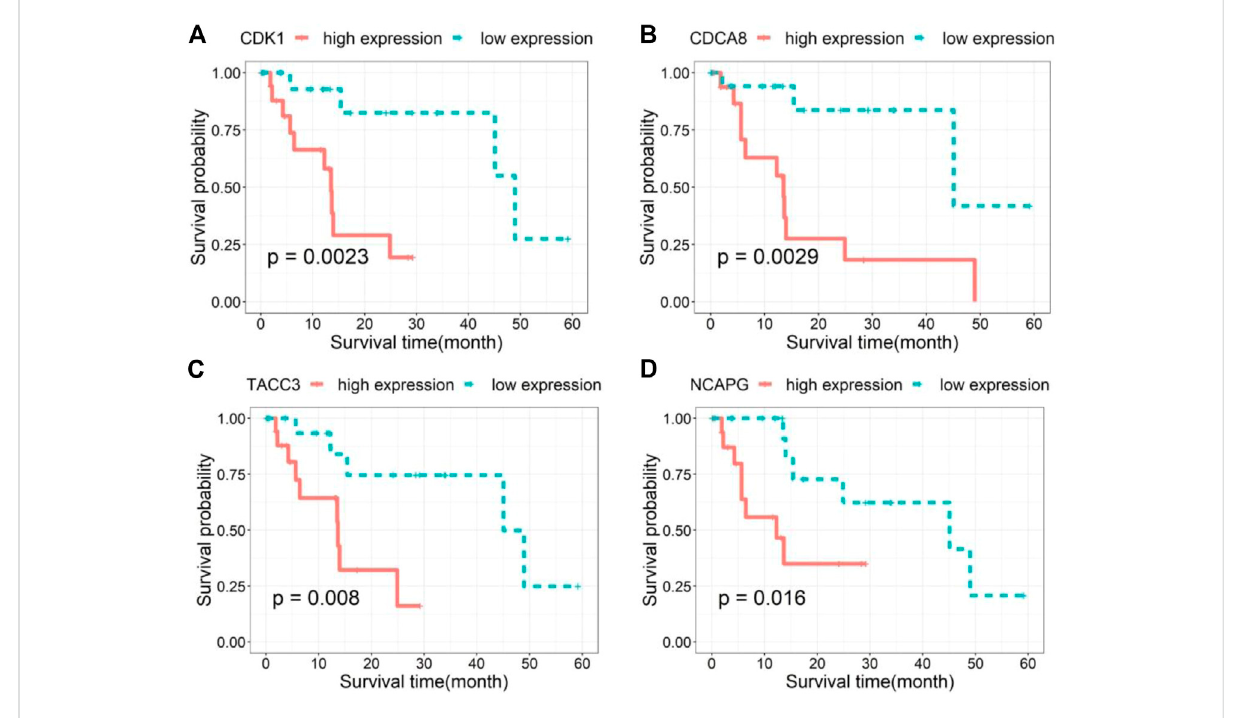
FIGURE 9 Survival curves (A – D) of the four hub genes sorted in ascending order of p